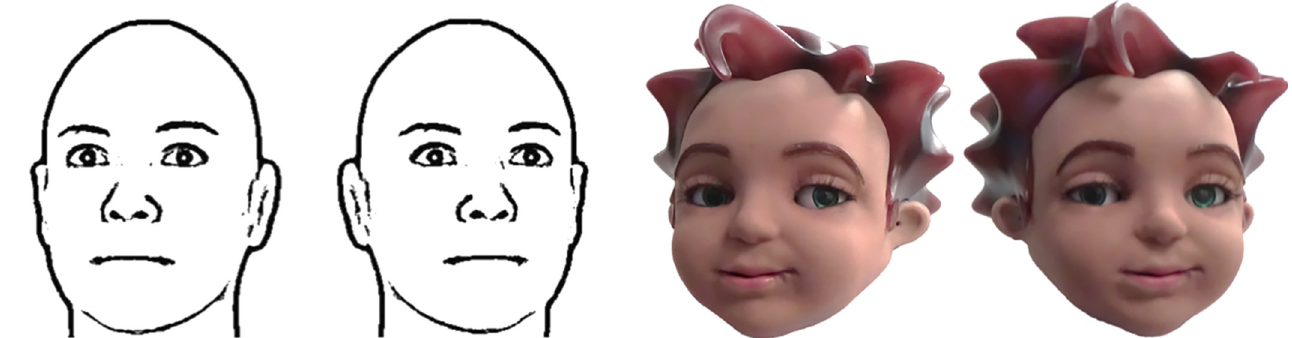
Fig 2. (A) Examples of stimuli from the 2D task and (B) pictures of Zeno from the 3D task. The 2D faces have identical eyes with +5˚ rotations superimposed on heads with -8˚ and +8˚ rotations. The faces from the 3D task have different combinations of head and eye rotations, but both look at the same point in space. The robot face on the left has a head rotation of -8˚ and an eye rotation of +13˚. The robot face on the right has a head rotation of +8˚ and an eye rotation of -3˚.